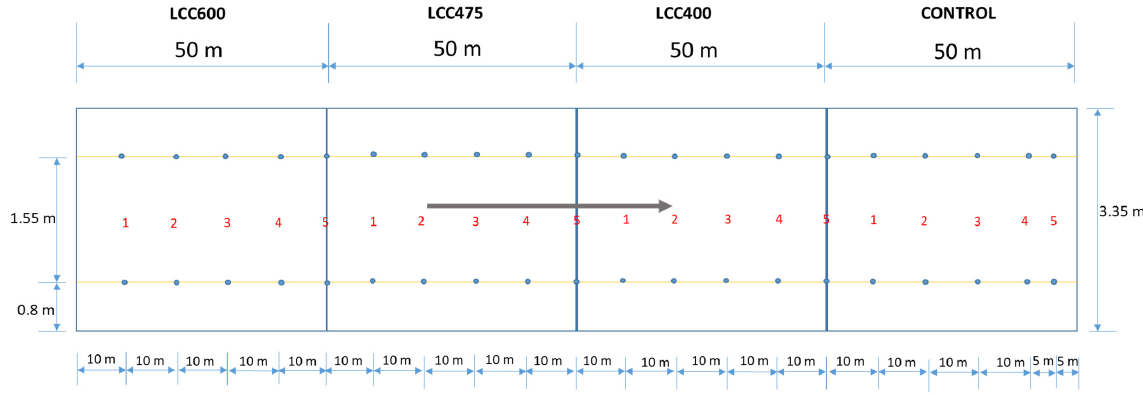
Figure 4. Lightweight deflectometer testing layout (Notre Dame Drive).